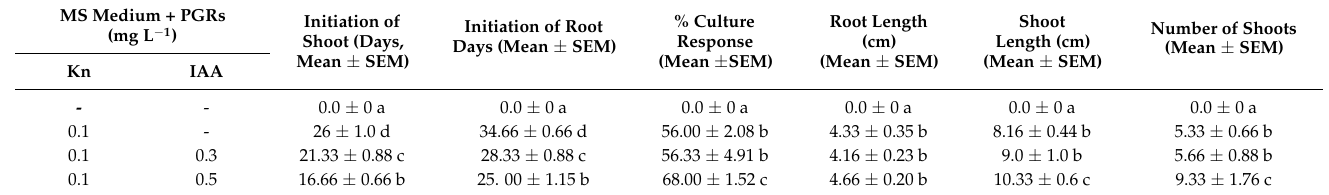
Table 3. Effect of Kn and IAA on whole plant regeneration from somatic embryos and in vitro root- ing in Aconitum violaceum. MS Medium + PGRs (mg L − 1 ) Initiation of Shoot (Days, Mean ± SEM)